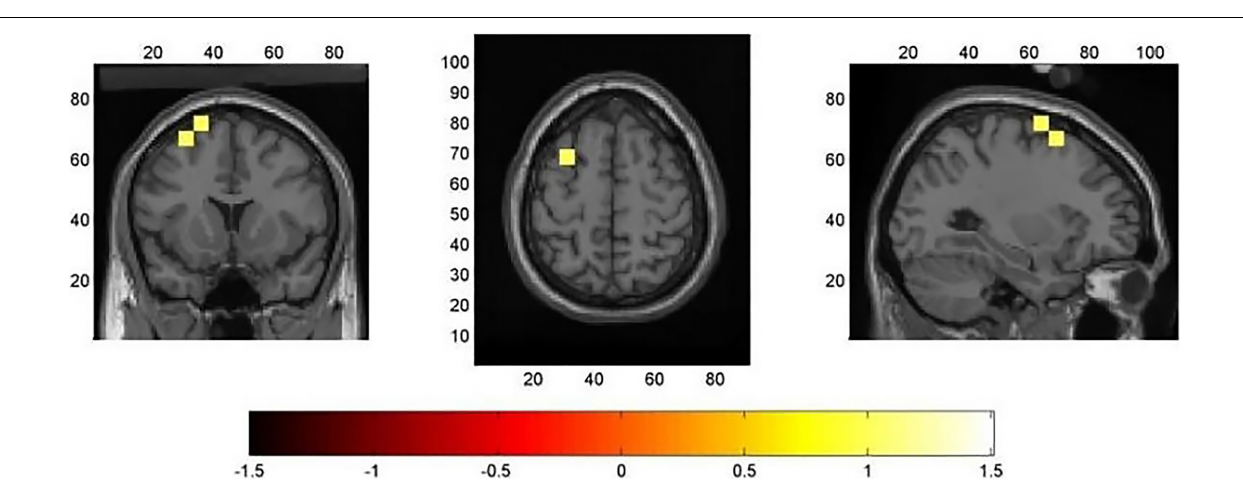
FIGURE 4 | Results of minimum norm estimate (MNE) source analysis in the time window of the N400 component (400–600 ms). The images represent the voxels in which the “low > high easy of learning (EOL) judgment” contrast was significant ( p < 0.05), and they have been corrected using a cluster permutation test. The significantly activated voxels are indicated by yellow